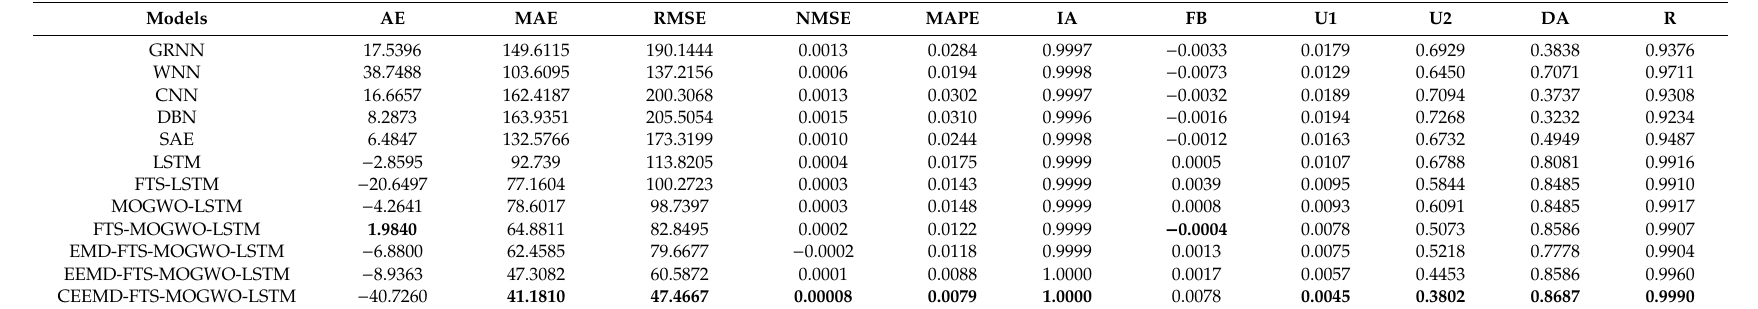
The values in bold indicates the best values of each benchmark